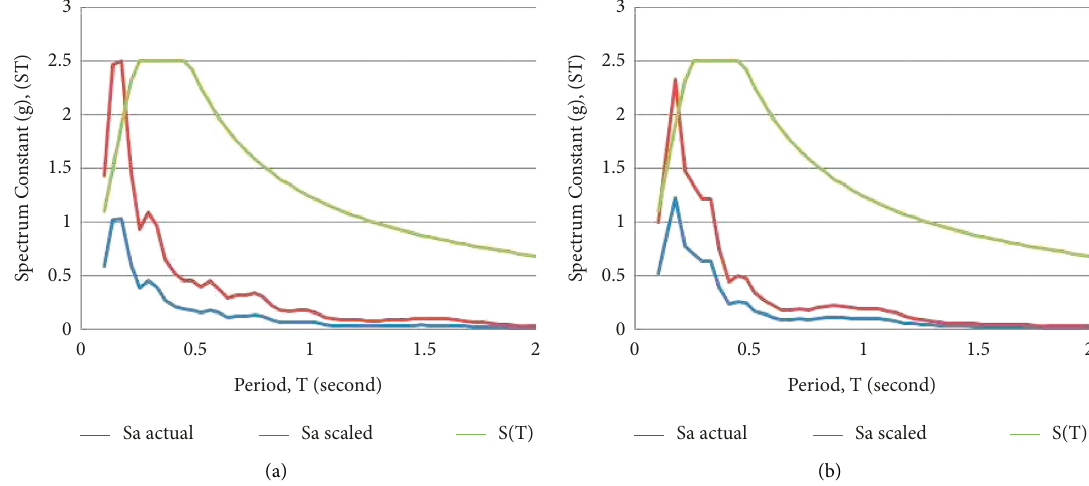
Figure 26: Evaluation of S(T) spectrum constants for (a) North-South (N-S) and (b) East-West (E-W) components of earthquake with epicenter at Sivas-Gemerek ( M W :